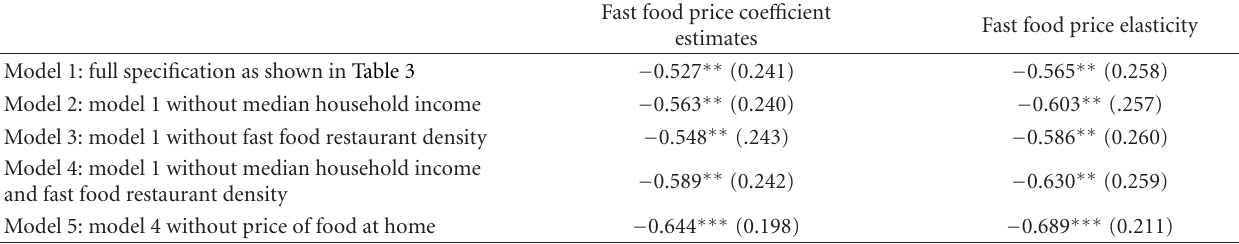
Table 3: Longitudinal regression estimates for individual-level random e ff ects model of the determinants of fast food consumption and price elasticity of consumption, by alternate model